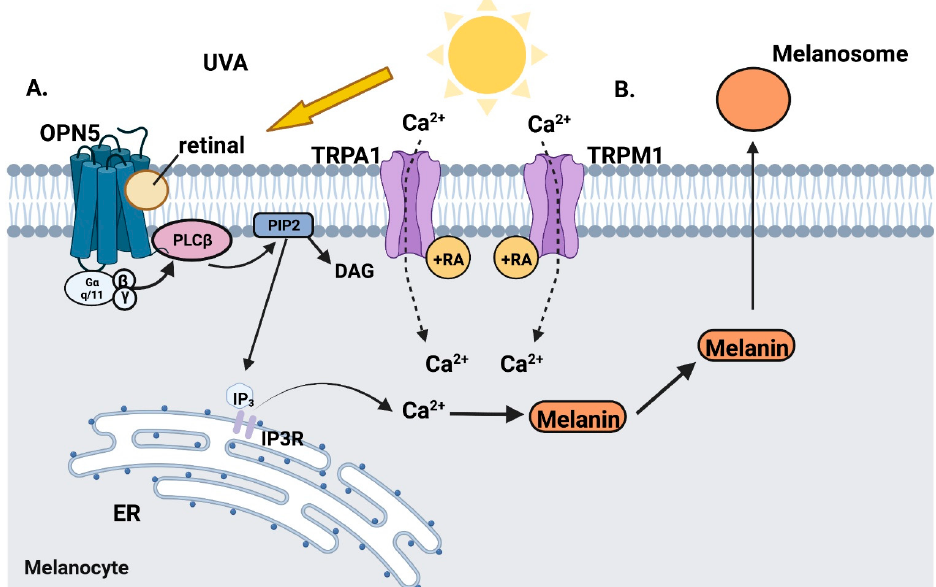
Figure 3. Retinal and melanogenesis: Pictured above are two retinal-dependent processes involved with melanogenesis. A. UVA stimulates retinal-dependent neuropsin (OPN5), which is a g-protein coupled receptor [82–84]. Phospholipase C β (PLC β ) is activated, which then cleaves phosphatidyl- inositol 4,5 bisphosphate into two parts: diacylglycerol and inositol triphosphate (IP3) [84]. IP3 binds